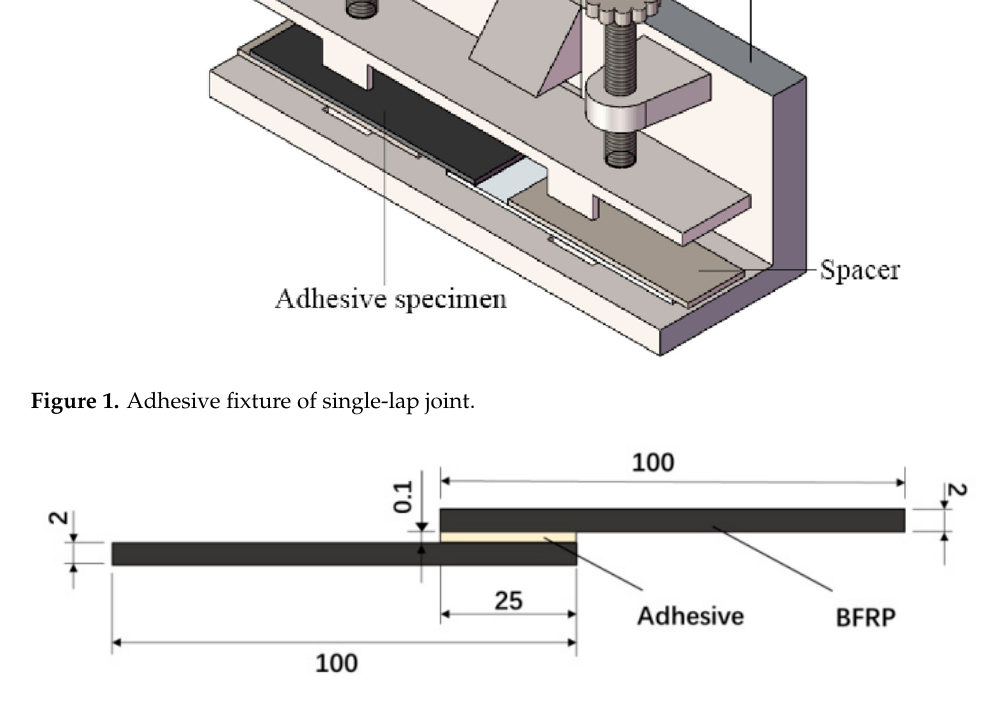
Figure 2. Geometry of single lap adhesive joint with 25 mm width (dimensions in mm).